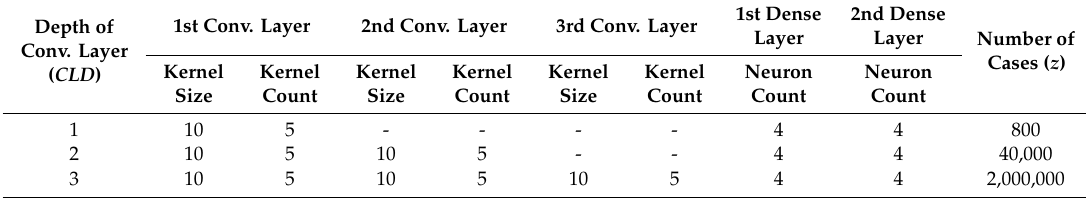
Table 3. Number of parameter combination cases according to Depth of Convolutional Layer ( CLD ). Depth of Conv.